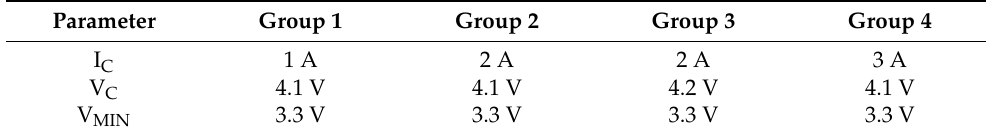
Table 5. Parameters used in each battery group.